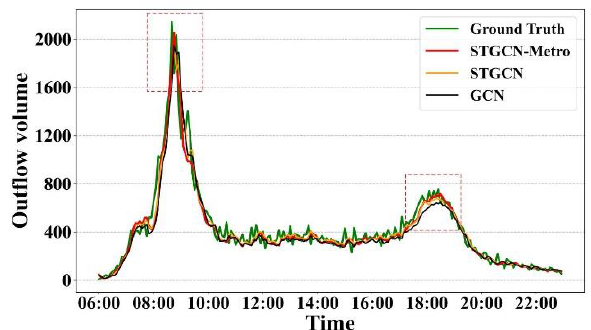
Figure 4 . Inflow volume prediction in weekday.